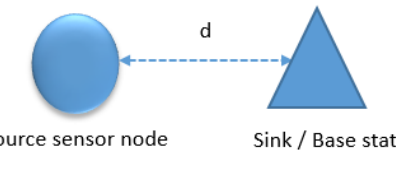
Figure 7. A single hop WSN model.